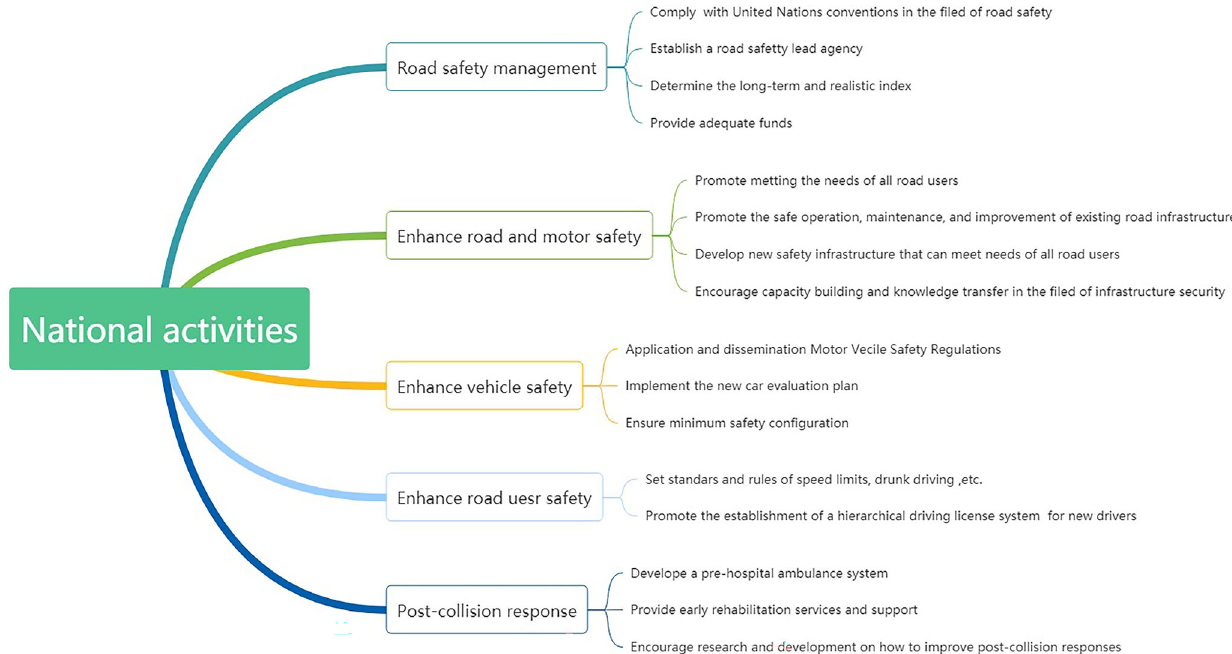
Fig. 1 Five pillars of national activites encouraged in the Decade of Road